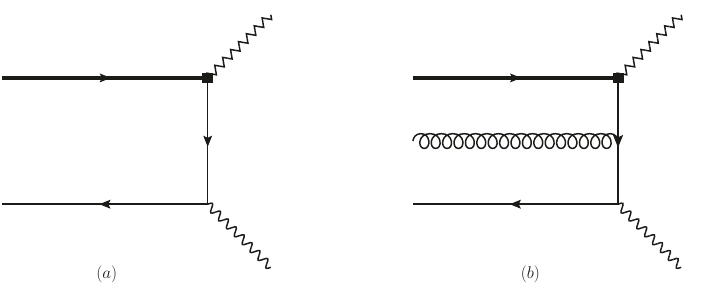
Figure 1 . The subleading power two-particle and three-particle corrections to the vacuum-to- bottom-meson correlation function (2.2) at the tree-level accuracy, where the square box indicates an insertion of the weak vertex ¯ q Γ and the waveline stands for the interpolating current ¯ q 0 /n γ µ b for the light pseudoscalar